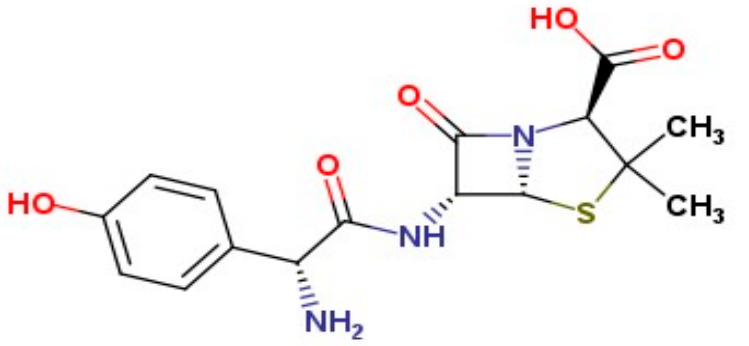
Figure 1. AMX Chemical structure.